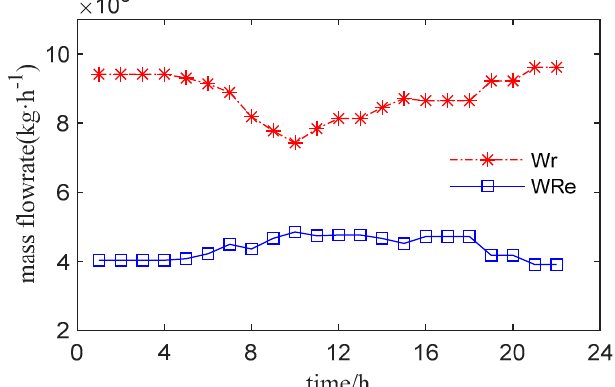
Figure 18. Trend of optimal operating parameters aiming at minimum TOC.